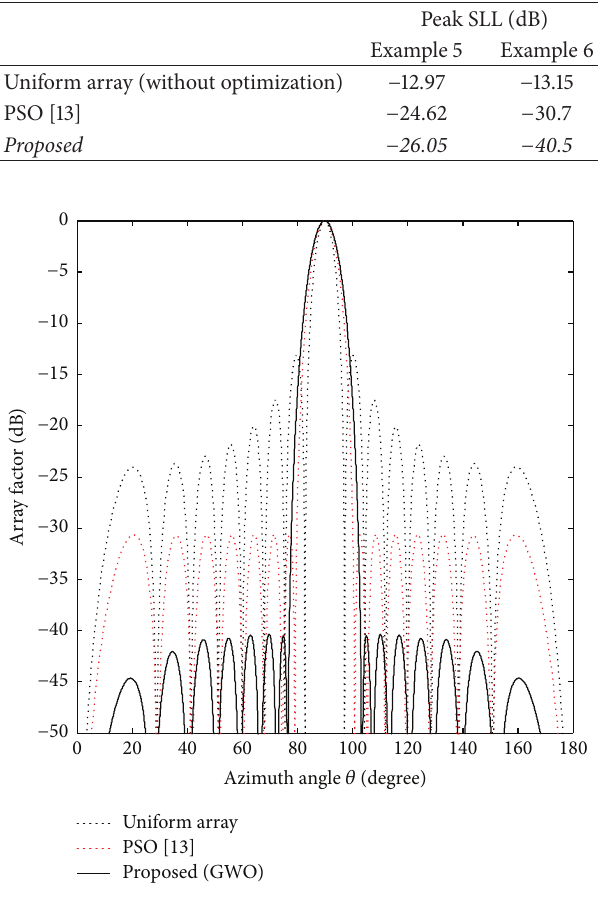
Figure 8: Array pattern for Example